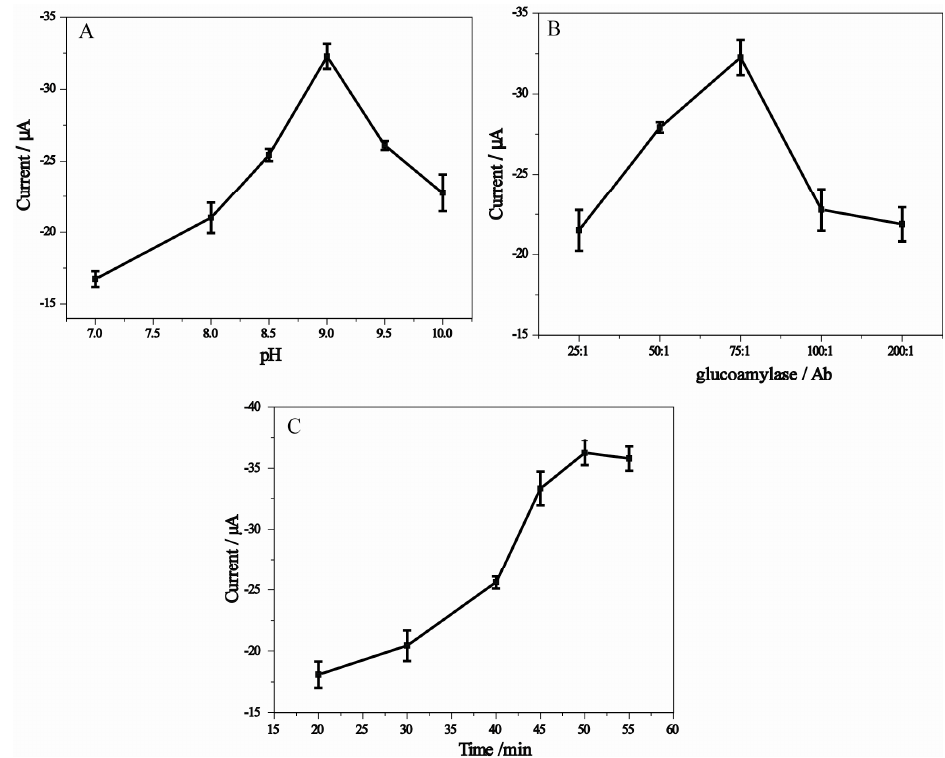
Figure 3. ( A ) Optimal pH for the conjugation of glucoamylase and Ab ratio on response current. ( C ) Effect of incubation time on the DPV of glucoamylase/Ab 2 peak